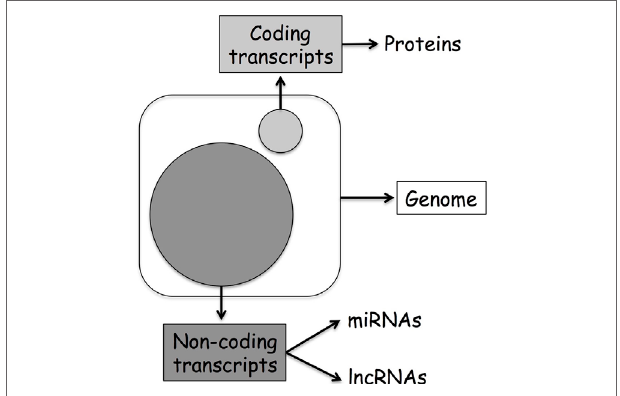
FigURe 1 | Human genome organization: coding vs. non-coding transcripts . The large circle represents ncDNA, while the small coding DNA. TAble 1 | Classes of non-coding RnAs.